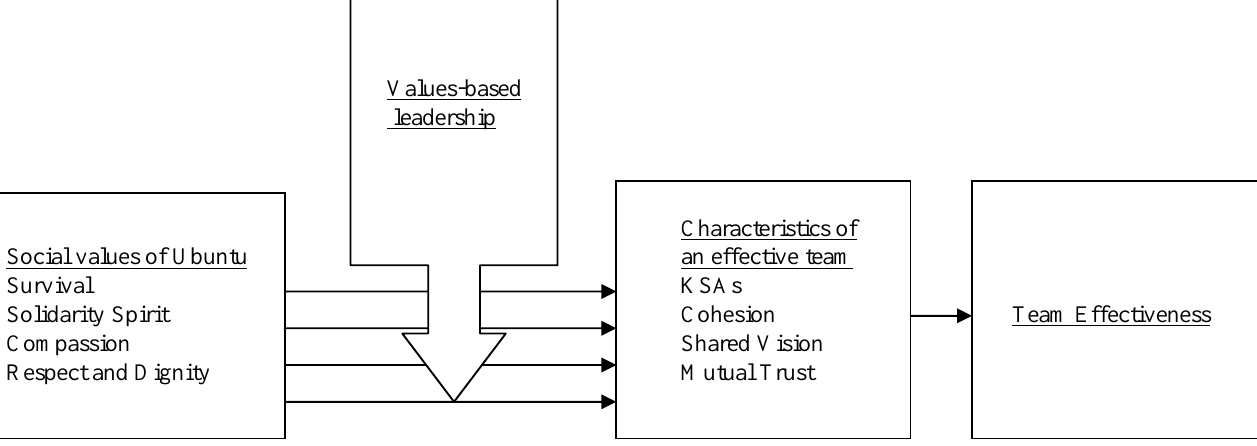
Figure 1: Theoretical model depicting the relationship between the social values of Ubuntu, values-based leadership, effective team characteristics and team